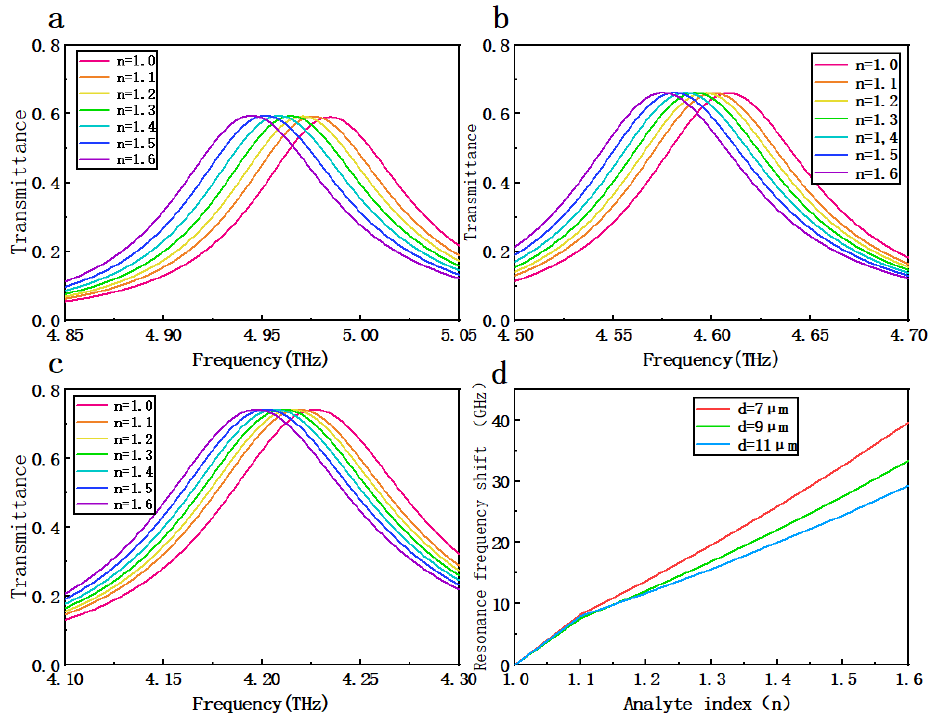
Figure 4. ( a ) The transmittance spectra of d = 7 µm; ( b ) d = 9 µm; and ( c ) d = 11 µm. ( d ) Comparison of the transmittance of these three hole diameters.